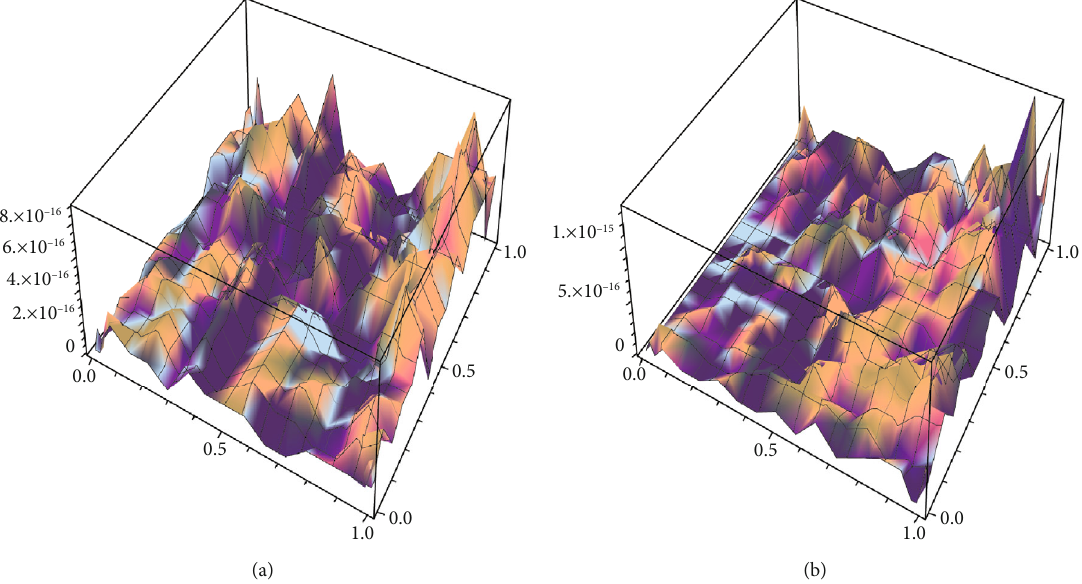
Figure 3: The absolute error between exact solution and tenth-order approximate solution: ð a Þ α = 2 and ð b Þ α = 1 : 6